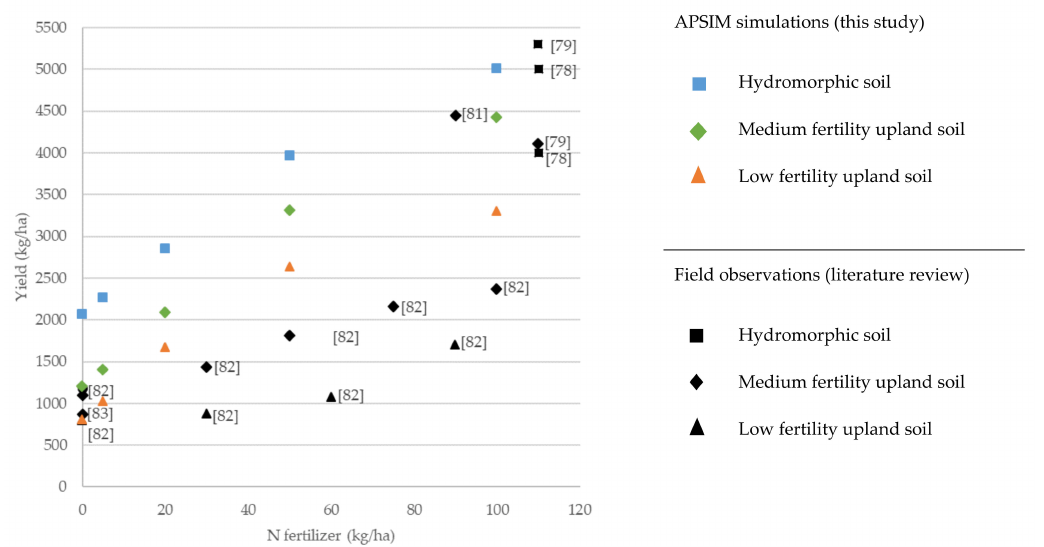
Figure 5. Rice simulated vs. published observed grain yields per fertilizer input level and soil fertility class. Numbers within brackets [] ([78,79,81–83]) indicate the reference of the publication from which data was